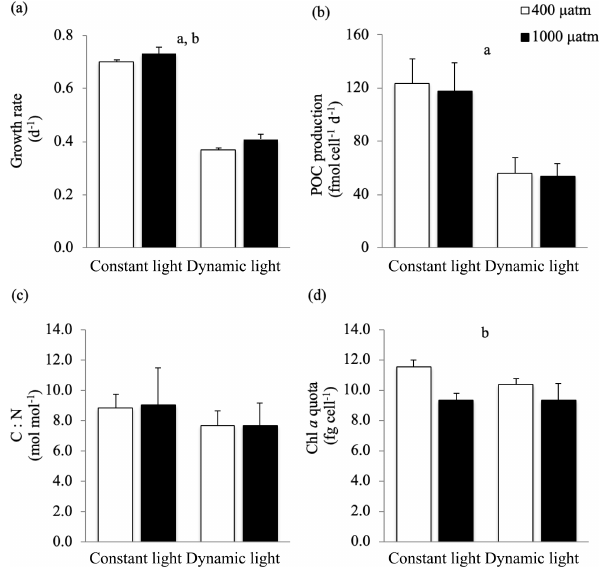
Figure 2. (a) Growth rate (d − 1 ), (b) POC production (fmolcelld − 1 ), (c) C:N ratio (molmol − 1 ), (d) chlorophyll a quota (fgcell − 1 ) of Micromonas pusilla under constant light and dynamic light and p CO 2 levels of 400µatm (white) and 1000µatm (black; n = 4; mean ± 1 SD). The letters indicate significant differences between treatments ( p < 0 . 05), represented as (a) light and (b) p CO 2